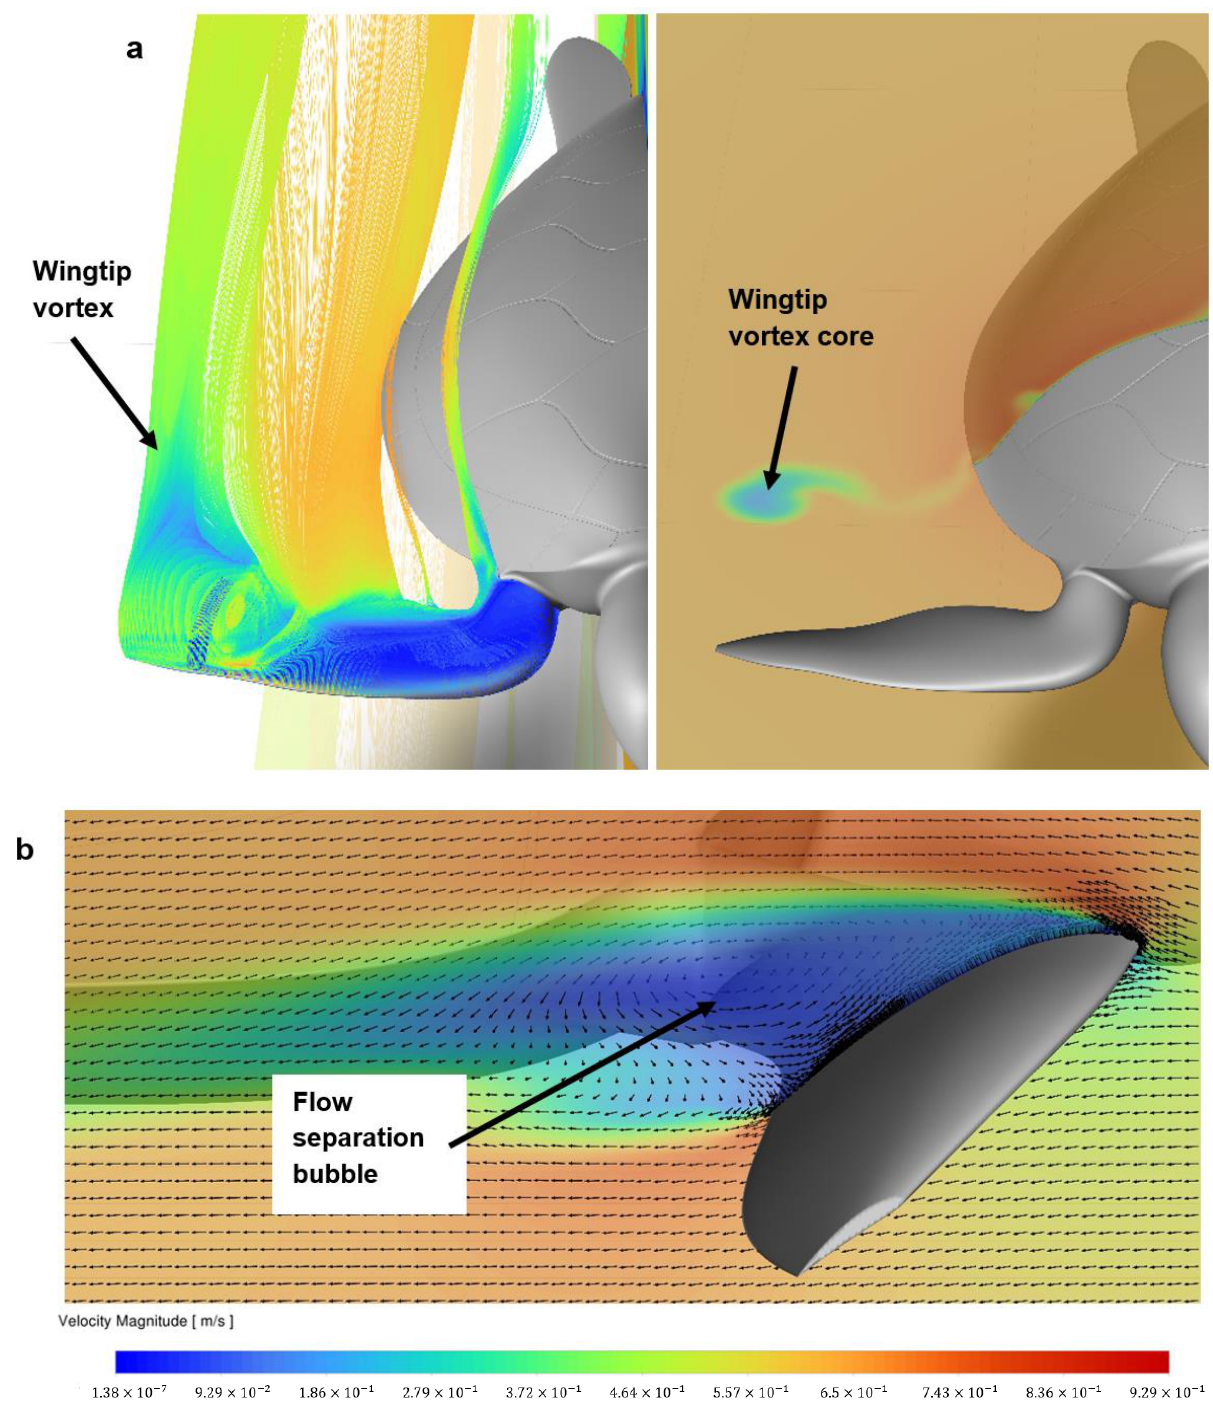
Figure 7. C.F.D. post-processing results of flow field velocity for a rigid wing of flex 35 ◦ . ( a ) Rigid wing generating the wingtip vortex. The image on the left shows streamlines starting at the turtle ’ s wing. The image on the right shows the vortex core via a transverse plane. ( b ) Longitudinal section plane through turtle wing showing flow separation due to adverse pressure gradients observed on rigid wings.